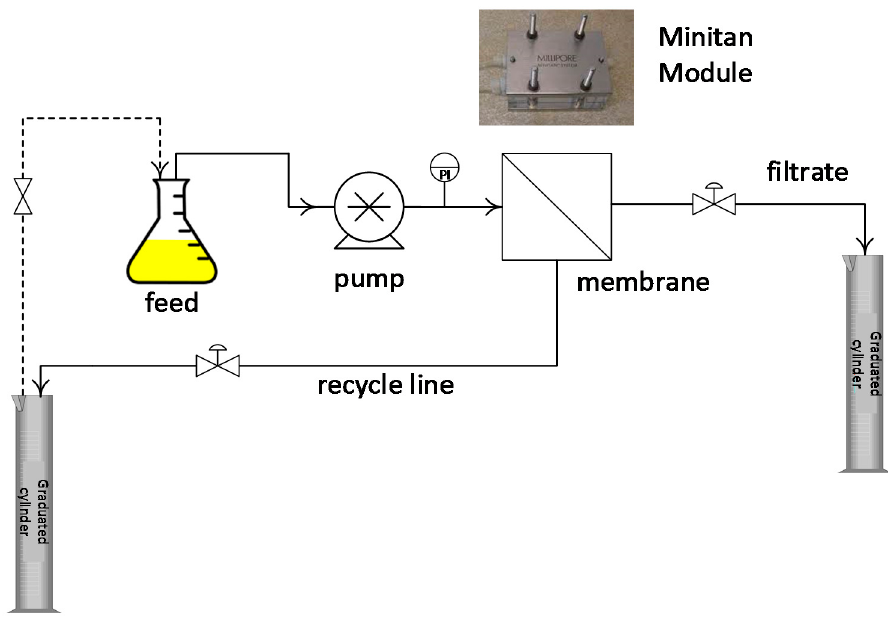
Figure 1. Sketch of the experimental lab scale membrane plant.